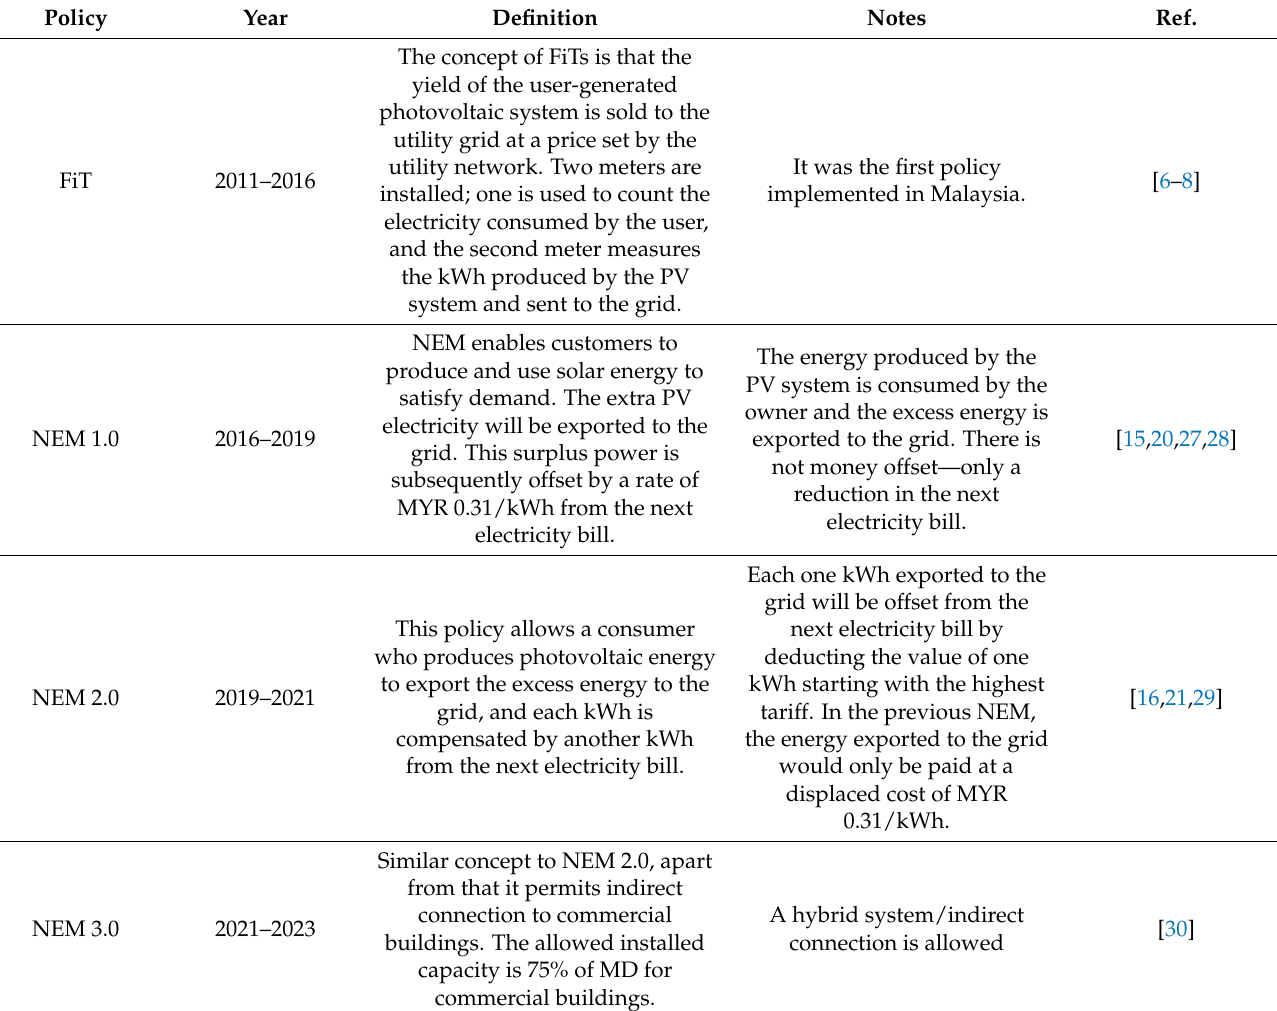
Table 1. PV policies in Malaysia applied to commercial